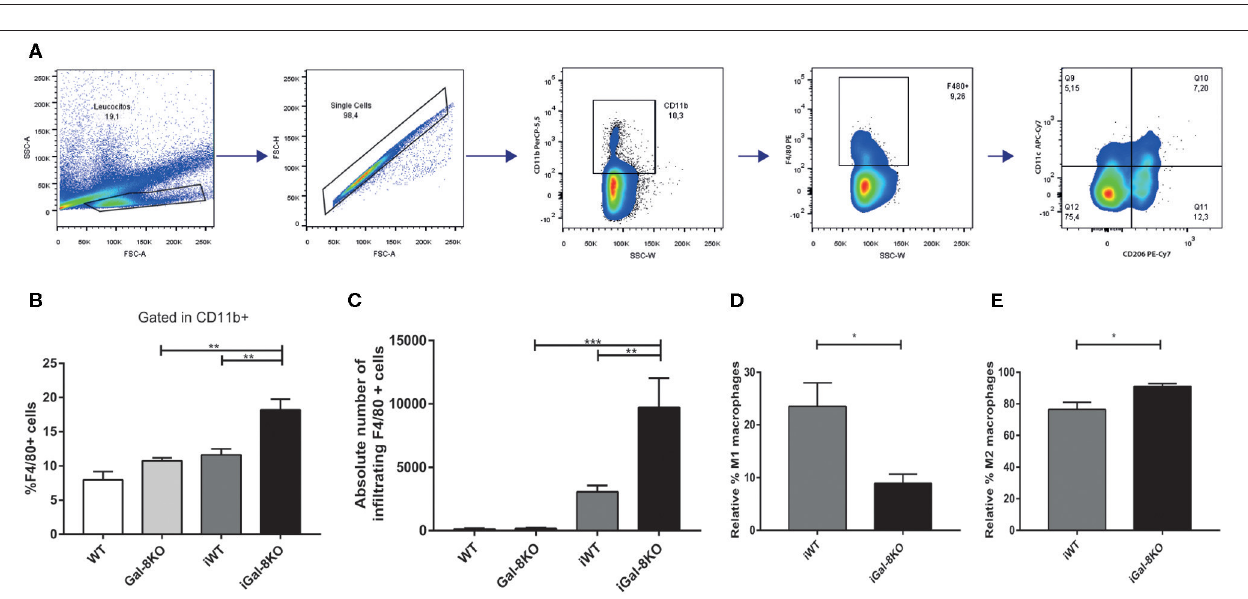
FIGURE 6 | Heart-infiltrating macrophages in infected Gal-8KO and wild-type (WT) mice. (A) Flow cytometry gating strategy for heart-infiltrating macrophages. (B) Percentage of CD11b + F4/80 + macrophages. (C) Absolute number of cardiac macrophages. (D) Relative percentage of F4/80 + CD11c + cd206– M1-type macrophages and (E) relative percentage of F4/80 + CD206 + CD11c + M2-type macrophages. Results are expressed as mean ± SEM cells of at least three independent experiments (5 animals/group). * P < 0.05; ** P < 0.01; *** P < 0.001. subpopulations showed that iWT hearts are enriched in M1-like inflammation and wound healing via fibrosis can be related population, whereas iGal-8KO hearts are predominant in the to M2 macrophages’ ability to synthesize ornithine, which is M2-like population. This predominance during a chronic involved in cell proliferation and collagen biosynthesis (Wynn